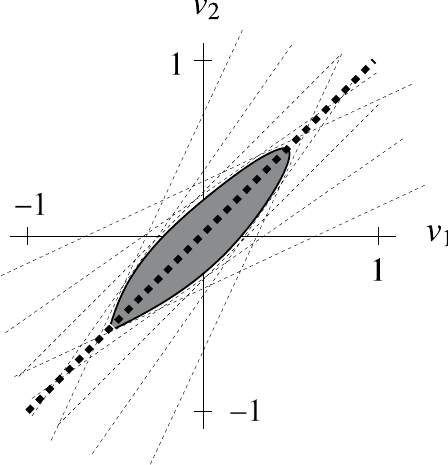
Figure 1. Graphical representation of the RAMP method. A depiction of the difference between an FBA (static) equality (the strong dashed line segment through the origin) and its stochastic RAMP counterpart (the bounded, shaded region). The light dashed lines represent the infinite set of linear constraints added by Eqns (10) and